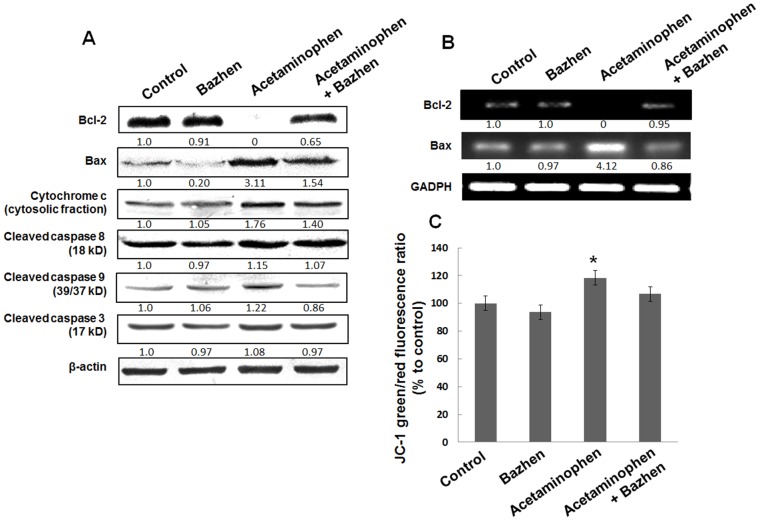
Effects of Bazhen decoction on apoptotic features in mice intoxicated with acetaminophen.(A) Western blotting of Bcl-2, Bax, cytochrome c (cytosolic fraction), cleaved caspase 8, 9 and 3 expressions. Data were normalized to β-actin used as control, (B) mRNA expression of Bcl-2 and Bax. GAPDH was used as internal control and (C) Fluorimetric quantified the green to red fluorescence ratio of JC-1. The value of control group was set as 100%.